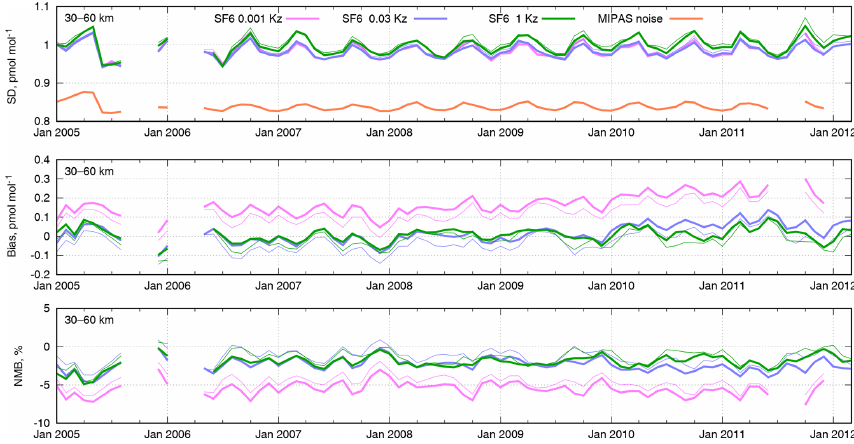
Figure 8. Same as in Fig. 7 but for the MIPAS altitude range of